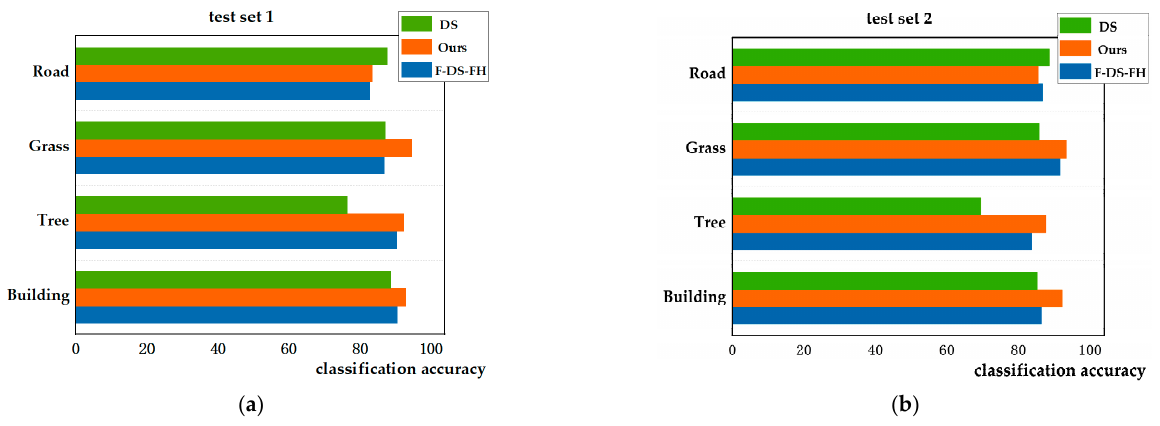
Figure 13. Averaged classification accuracy: ( a ) test set 1; ( b ) test set 2.